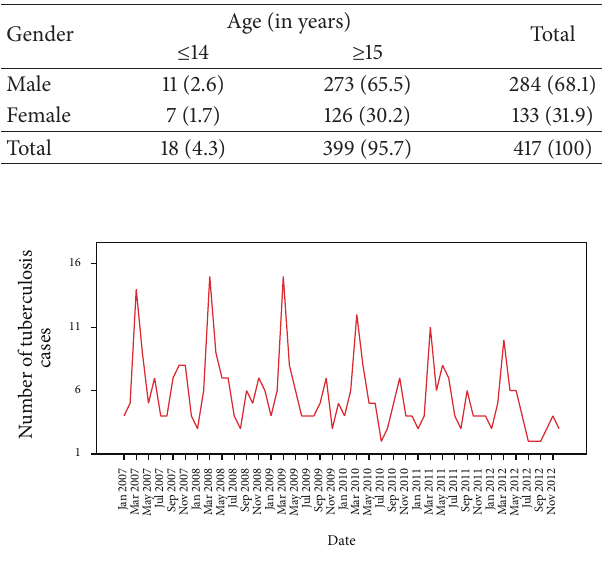
Figure 1: Sequence chart of total number of tuberculosis.